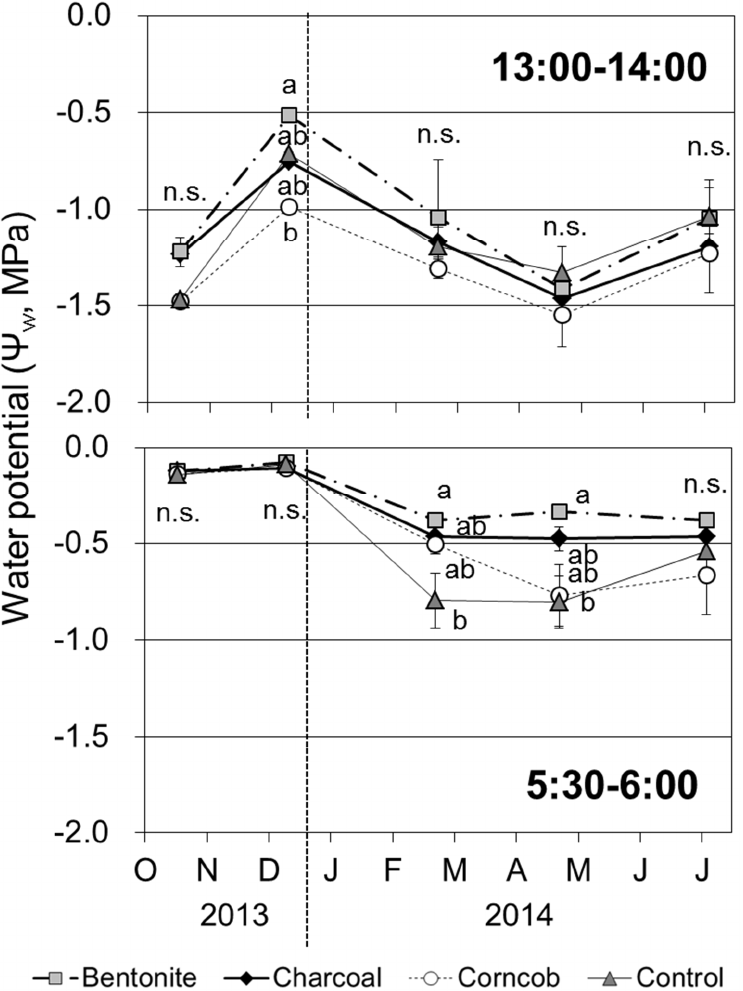
Figure 7. Leaf water potential in the afternoon (1–2 p.m.) and predawn (5:30–6:00 a.m.) for teak seedlings grown in the four treatments (Mean ± SE, n = 4).